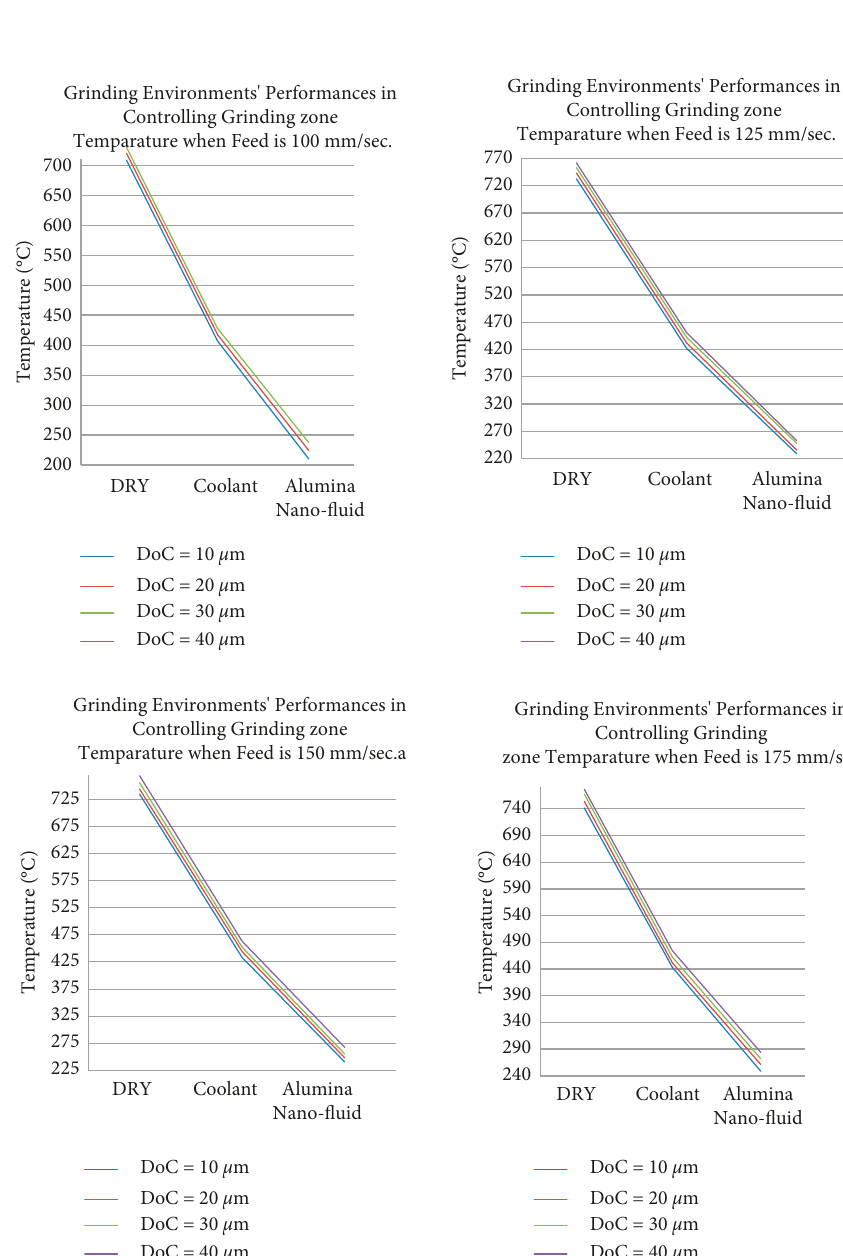
Figure 2: Cutting zone temperature reduction performance of machining environment at constant feed.